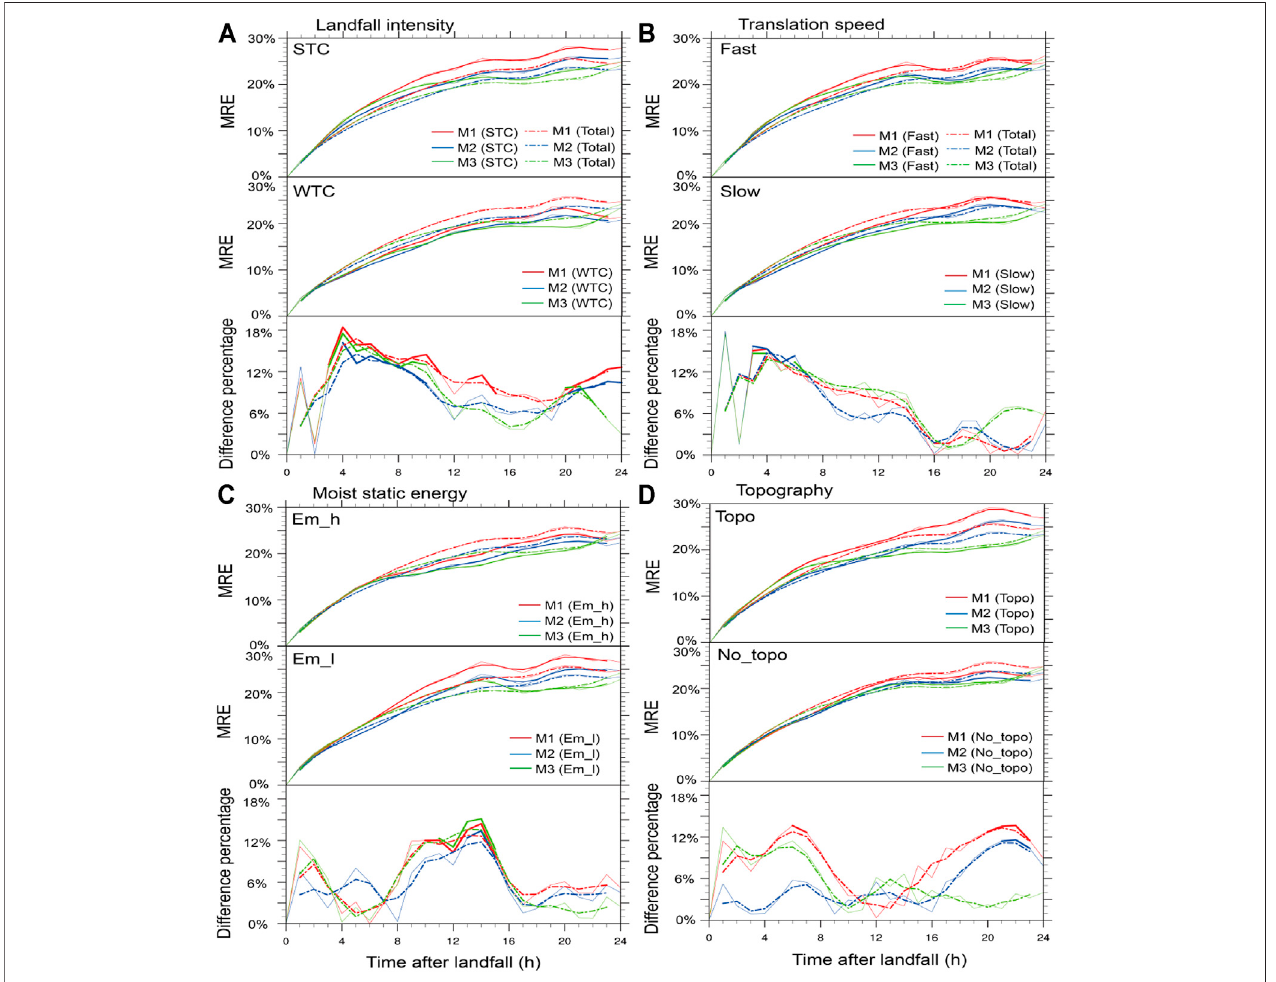
FIGURE10| Meanrelativeerrors(MRE)ofallsamplesoflandfallingTCs(dashed)andtheMREsofdifferentclassi fi cationgroups(solid)intheupperandmiddlepart of each panel, and the percentage of difference in MREs between different groups and all TCs in the lower panels. The solid portions in the lower panels indicating the difference being statistically signi fi cant over 90% con fi dence level, for (A) landfall intensity, (B) translation speed, (C) moist static energy, (D) topography.